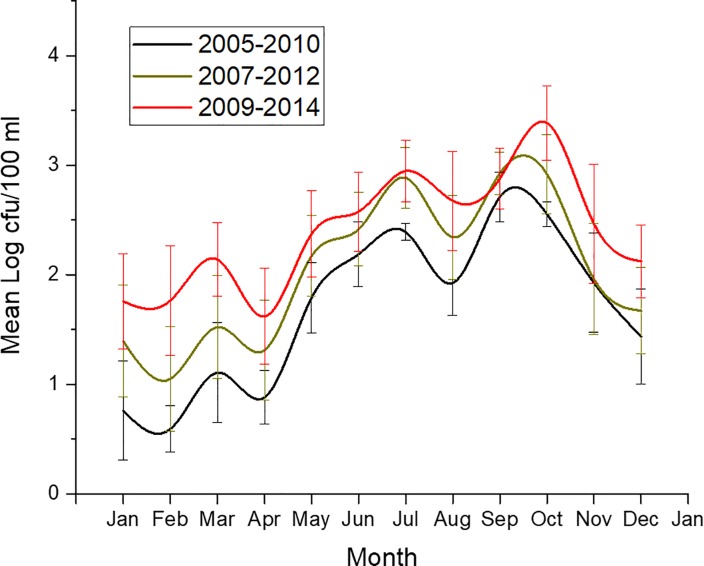
Monthly six-year average of Vibrio spp. observed during the first (black line), middle (tan line), and last (red line) six years of study duration at station 70S.Error bars are standard error of the mean.